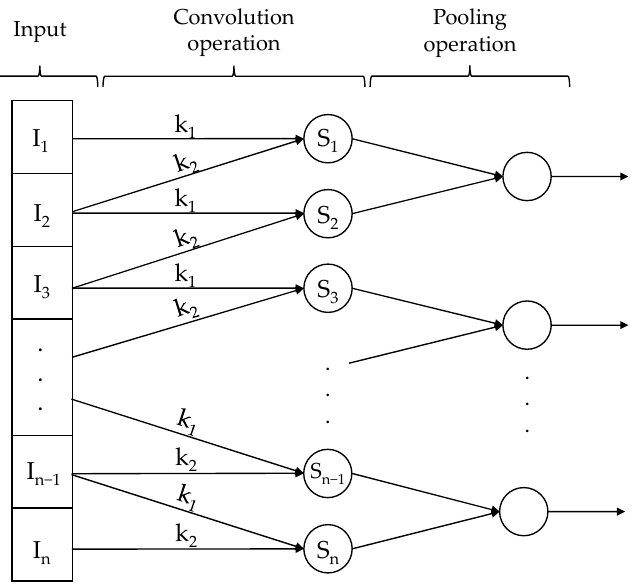
Figure 3. Visualization of convolution and pooling operations for a one-dimensional input.